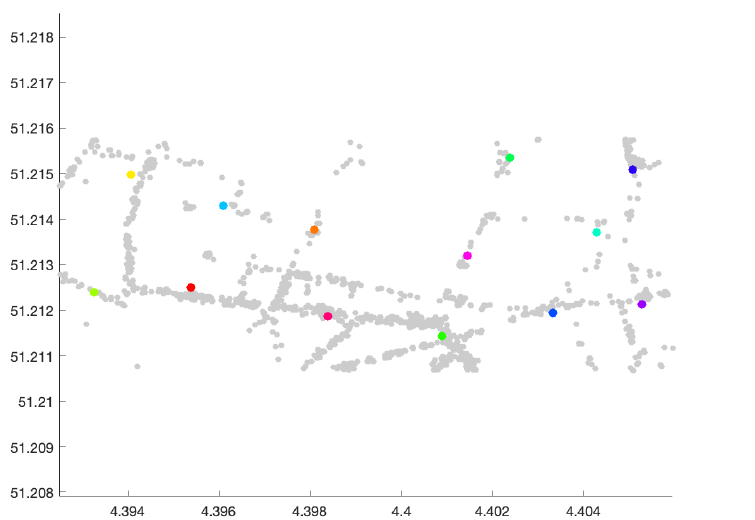
Figure 5. This figure shows the centroids of clusters obtained in the central Area of Antwerp: (see Figure 4) Lat ∈ [ 4 ◦ 23 (cid:48) 00 (cid:48)(cid:48) ,4 ◦ 24 (cid:48) 00 (cid:48)(cid:48) ] – Long ∈ [ 51 ◦ 12 (cid:48) 00 (cid:48)(cid:48) ,51 ◦ 13 (cid:48) 00 (cid:48)(cid:48) ]